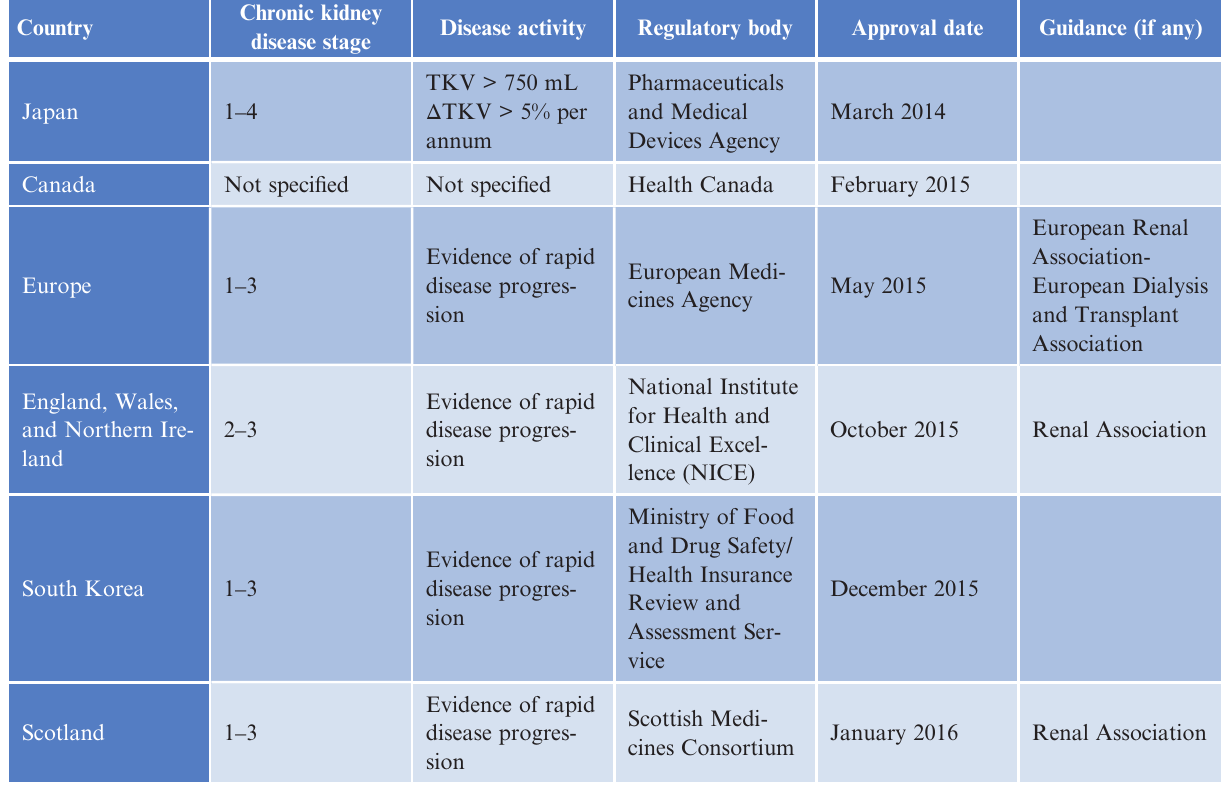
Table 1. Eligibility criteria for the approved use of tolvaptan according to country or